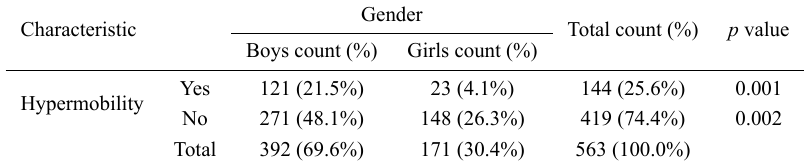
Table 2. Generalized joint hypermobility and gender.